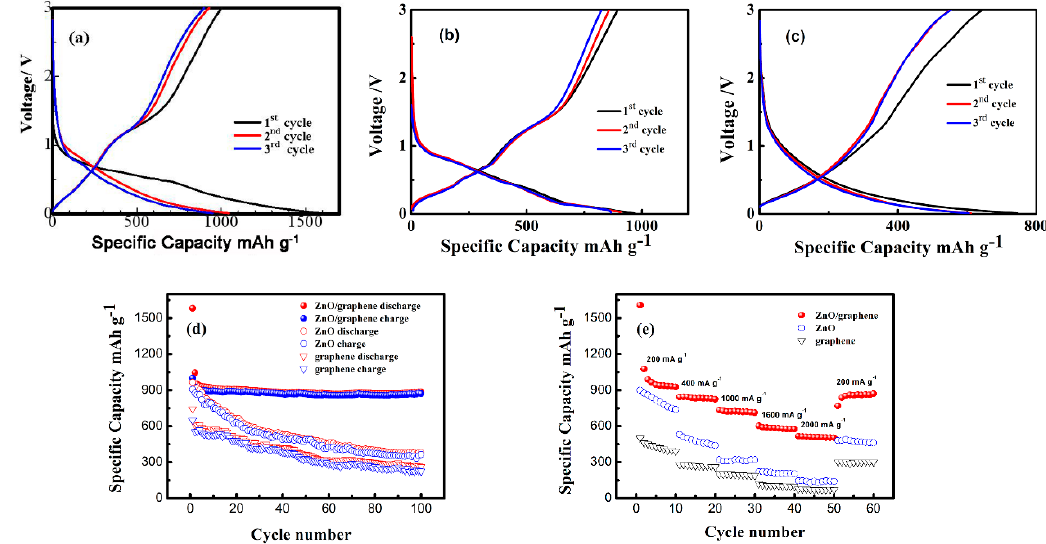
Figure 8. ( a – c ) Charge–discharge curves of the ZnO/graphene, ZnO and graphene. ( d ) Cycle performance of the ZnO/graphene, ZnO and graphene anodes at 200 mA g − 1 . ( e ) Rate capability of the ZnO/graphene, ZnO and graphene anodes.